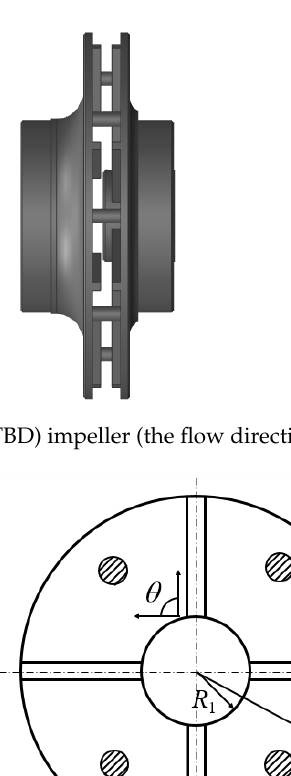
Table 1. Literatures related to the Tesla bladed pump.